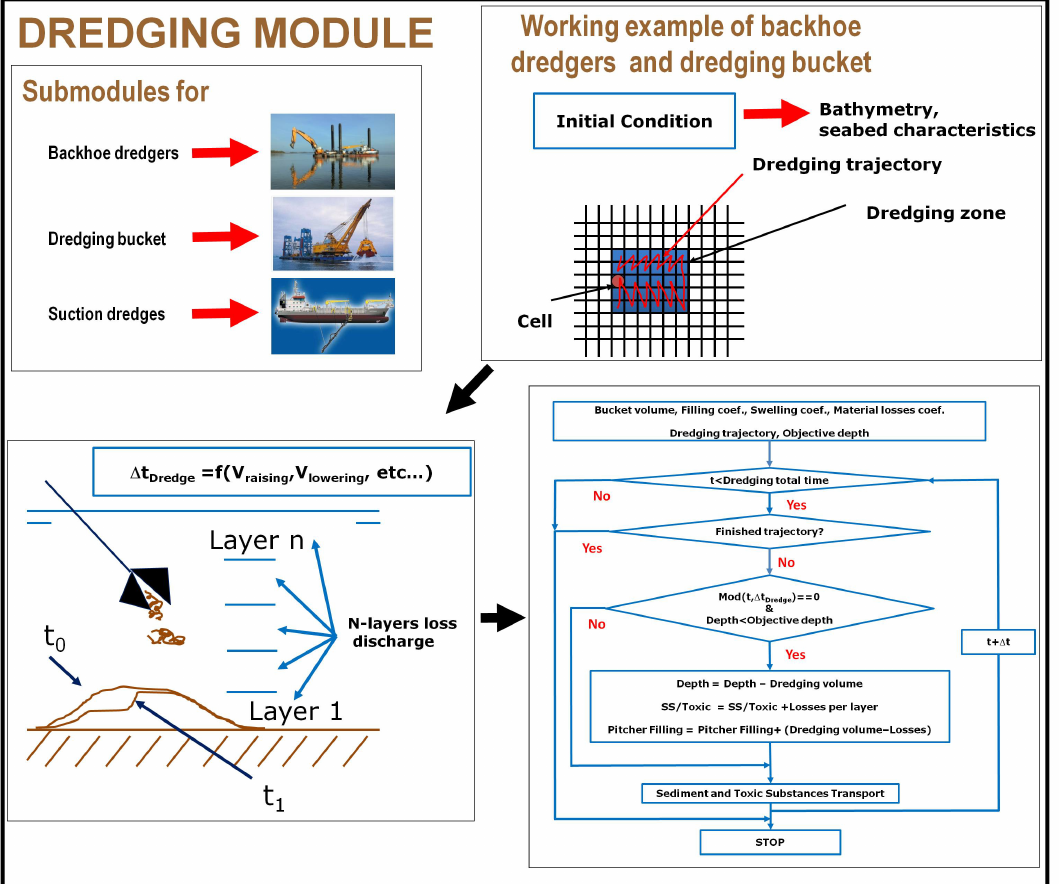
Fig. 1. Example of IH-Dredge working